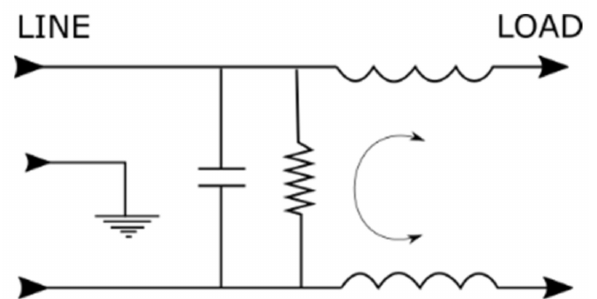
Figure 3. Filter electrical schematic for IEC PS00XDH3A